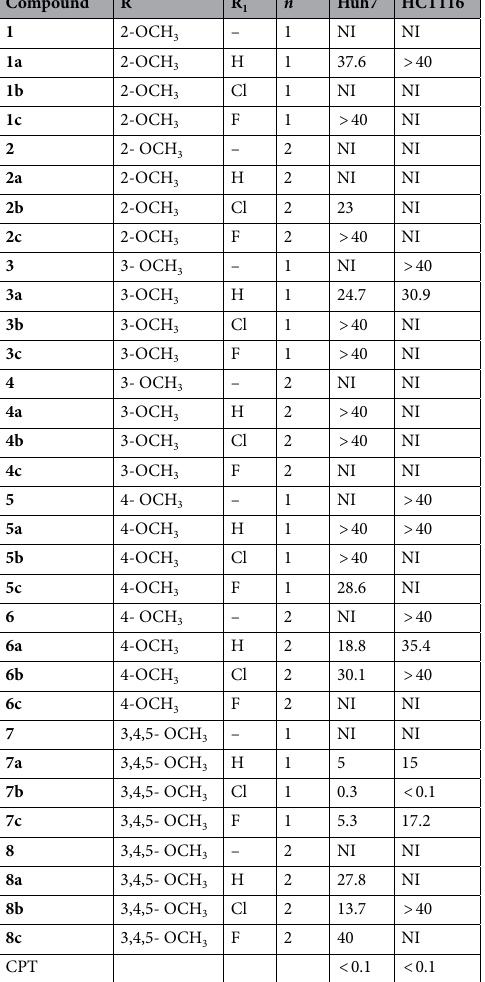
Table 1. IC 50 values of 4-amino-3-substituted-1,2,4-triazole-5-thiones ( 1–8 ) and 3,6-disubstituted 1,2,4-triazolo[3,4-b]-1,3,4-thiadiazines ( 1a-8c ) determined by SRB assay. *NI: no inhibition.